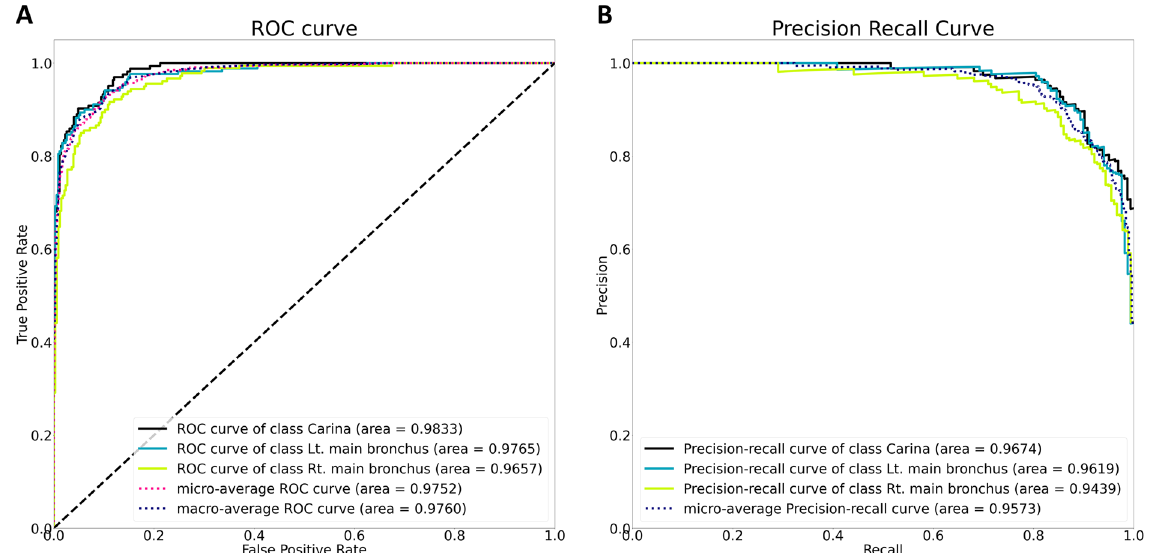
Figure 4. The area under the receiver operating characteristic curve and precision-recall curve of the artificial intelligence model for distinguishing anatomical